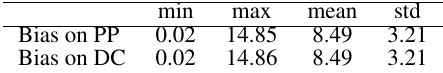
Table 3. Statistics of the variation of camera distortion